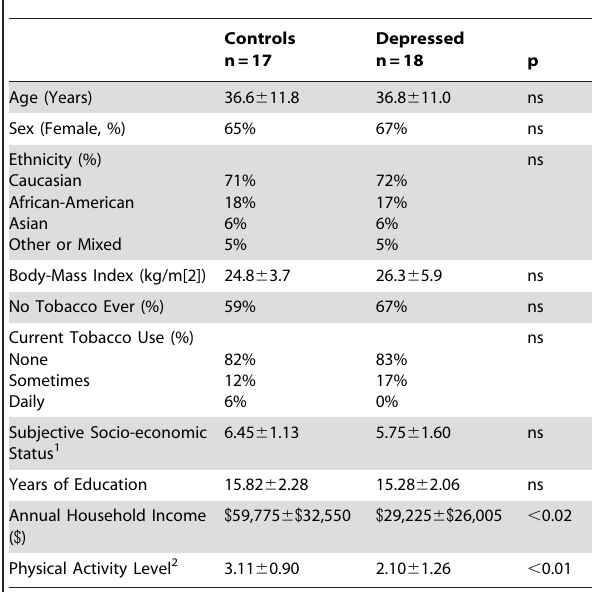
Table 1. Characteristics of Depressed and Control